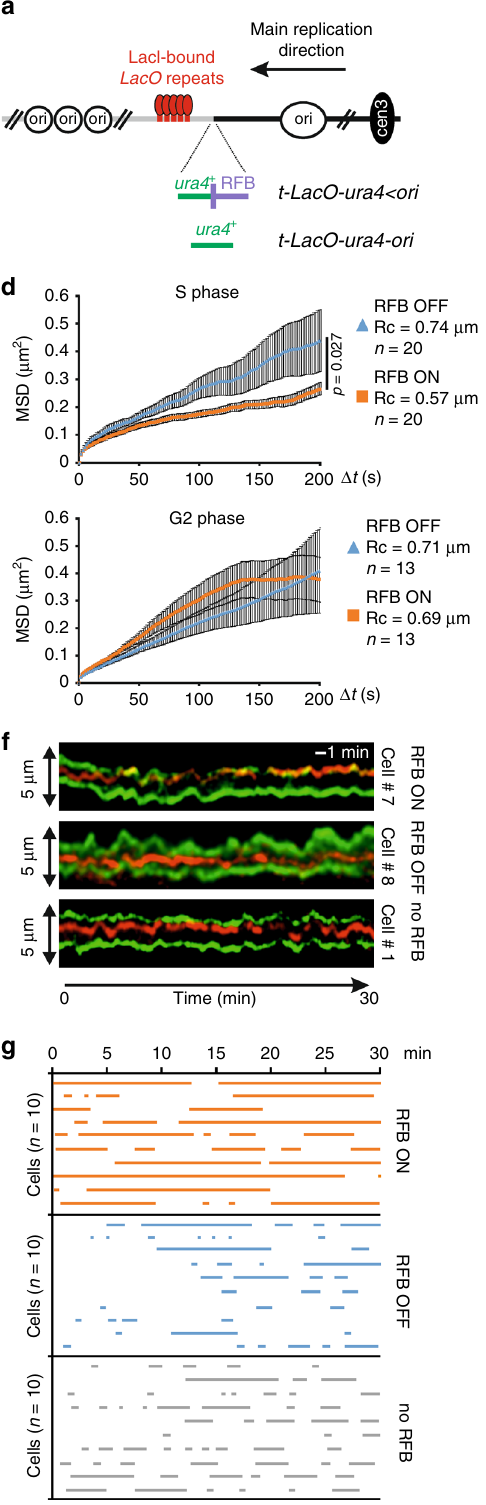
(RFB OFF) or absent from the ura4 + locus (no RFB, Fig. 1a), LacI-foci co-localized with the NP in ∼ 45% of both S and G2- phase cells (Fig. 1c). Upon activation of the RFB (RFB ON), the LacO -marked RFB was located more frequently at the NP in S- phase cells, ∼ 70% of the time, but not in G2 cells. Thus,